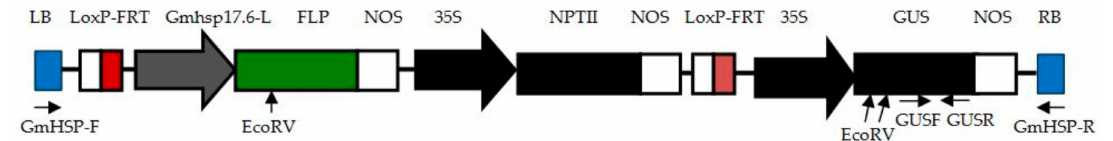
Figure 1. Schematic representation of the pCaLFGmFNLFG vector used for plant transformation. Flipping DNA ( FLP ) transcription is induced by the heat-shock promoter Gmhsp17.6-L from soybean. The GUS and NPTII genes are under the control of the CaMV 35S promoter. LB: Left border, LoxP-FRT : Fusion recognition sites, Gmhsp17.6-L: A heat-shock-inducible promoter from soybean, NOS: Polyadenylation sequence of the nopaline synthase gene, 35S: CaMV 35S promoter, GUS: Glucuronidase gene, NPTII: Neomycin phosphotransferase gene, RB: Right border, GmHSP-F, GUSF, GUSR, GmHSP-R: Primers binding sites, Eco RV: Restriction enzyme